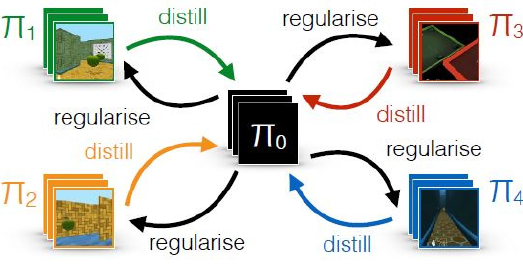
Figure 4. Architecture of the DISTRAL framework.